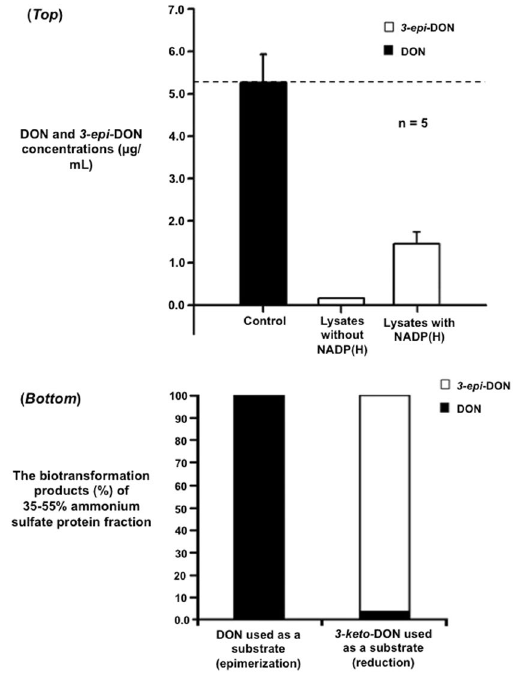
Figure 5. DON epimerization in cell-free lysates of Devosia mutans and the enzymatic activity of selected ammonium sulfate protein fractions of Devosia mutans . ( Top ): Whole cell-free lysates of bacteria (n = 5) were incubated for two hours with DON (as substrate) without any added cofactors or with NADP(H) at 100 µ M. Concentrations of DON and 3-epi- DON were determined by HPLC-MS/MS methods. ( Bottom ): The 35–55% ammonium sulfate protein fraction prepared as reported earlier in the Materials and Methods section was tested for the enzymatic activity by adding DON or 3-keto -DON (as substrates) separately with a source of NADP(H). After an overnight incubation, the concentrations of DON, 3-keto- DON and 3-epi- DON were determined by HPLC-MS/MS methodology. While experiments were conducted in triplicates to confirm the observed tendencies, no quantitative statistical inferences between reactions are suggested for the bottom part of the